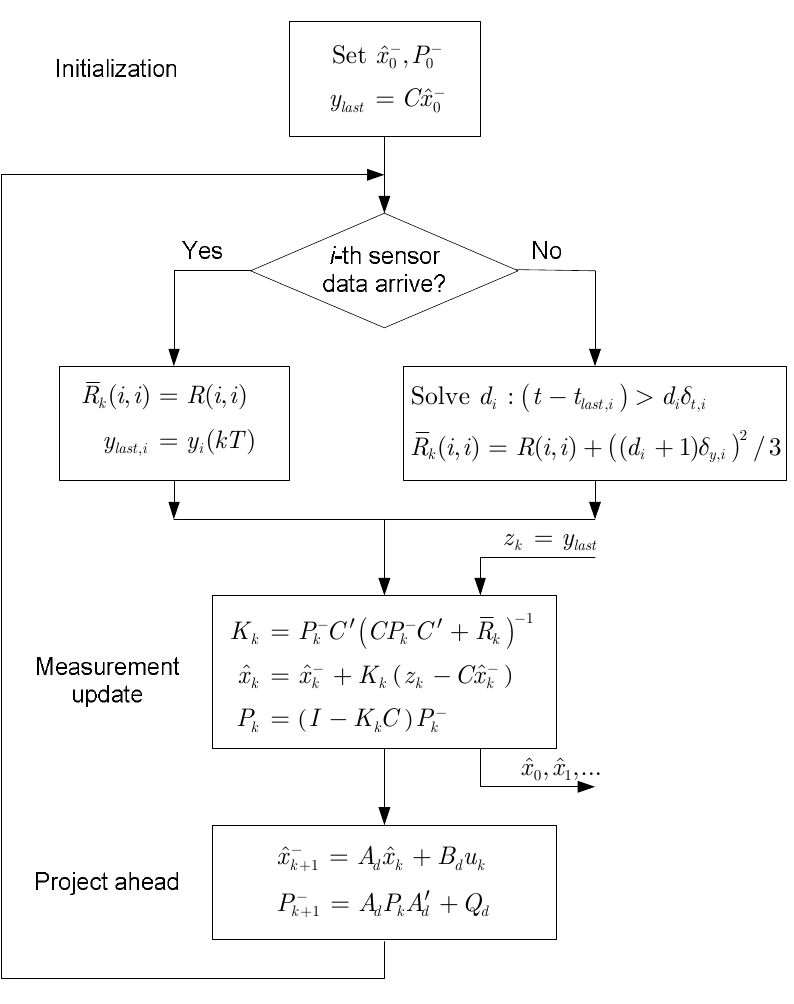
Figure 4. Structure of the modified Kalman